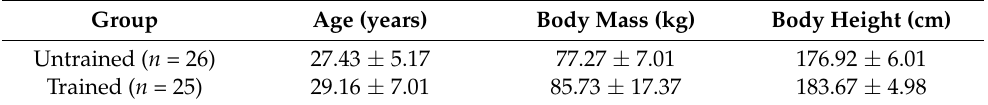
Table 1. Sample descriptive